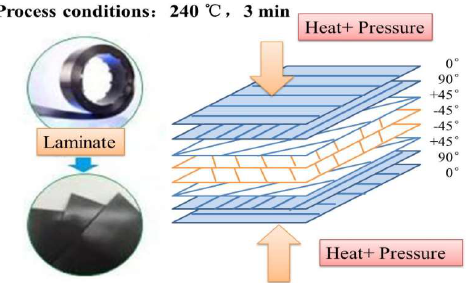
Figure 1. Schematic diagram of forming process for prepreg laminate.